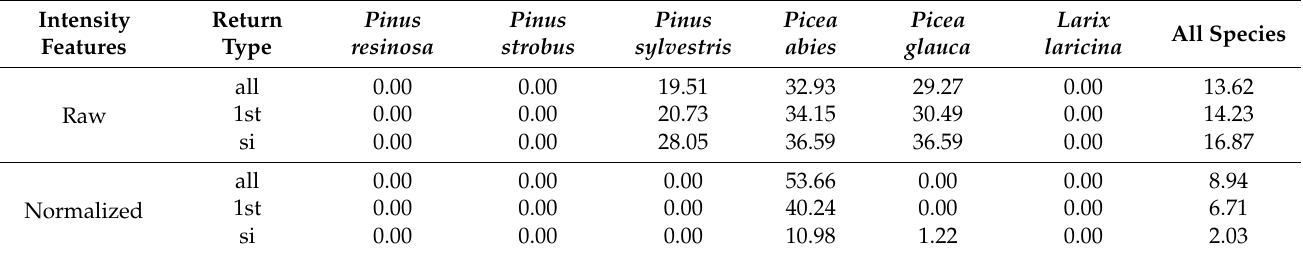
Table 6. Percent of features with a correlation ( r ) greater than | ± 0.2| between mean scan angle and feature values by return type and by species. Cases that were greater than 15% are